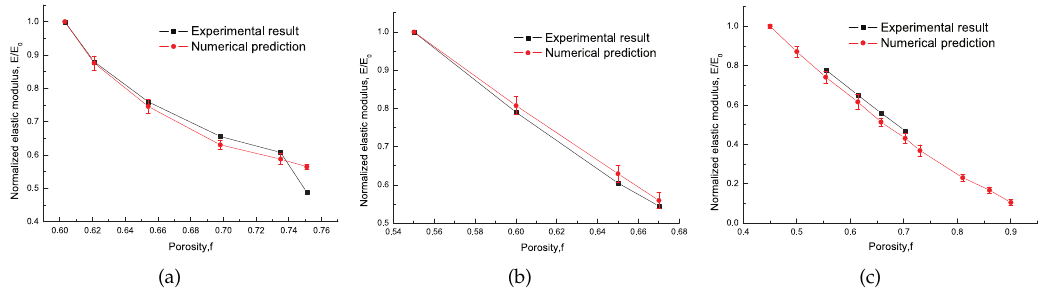
Figure 12. Numerically predicted effective elastic isotropic moduli together with the experimental results of ( a ) porous titanium, ( b ) porous CoCrMo alloy and ( c ) porous tantalum.